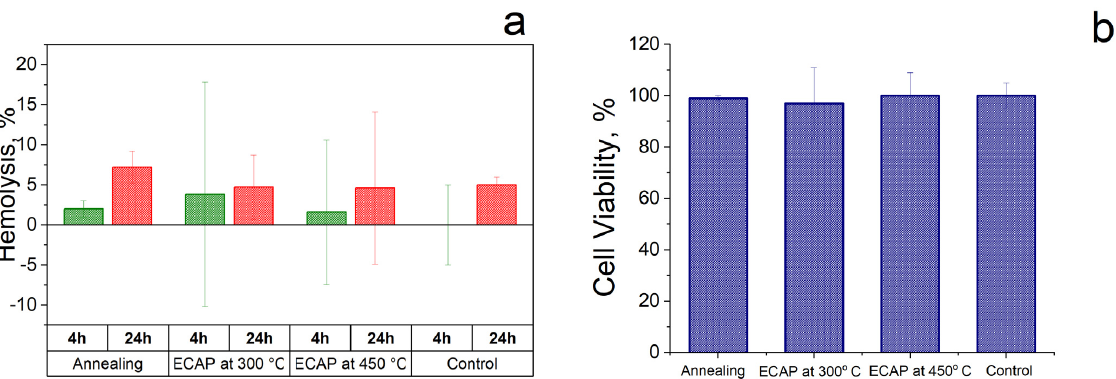
Figure 7. Study of the biocompatibility of Fe–Mn–Pd alloys in the initial state and after ECAP treatment by assessing the change in hemolysis ( a ) and cell viability ( b ) in comparison with the control.